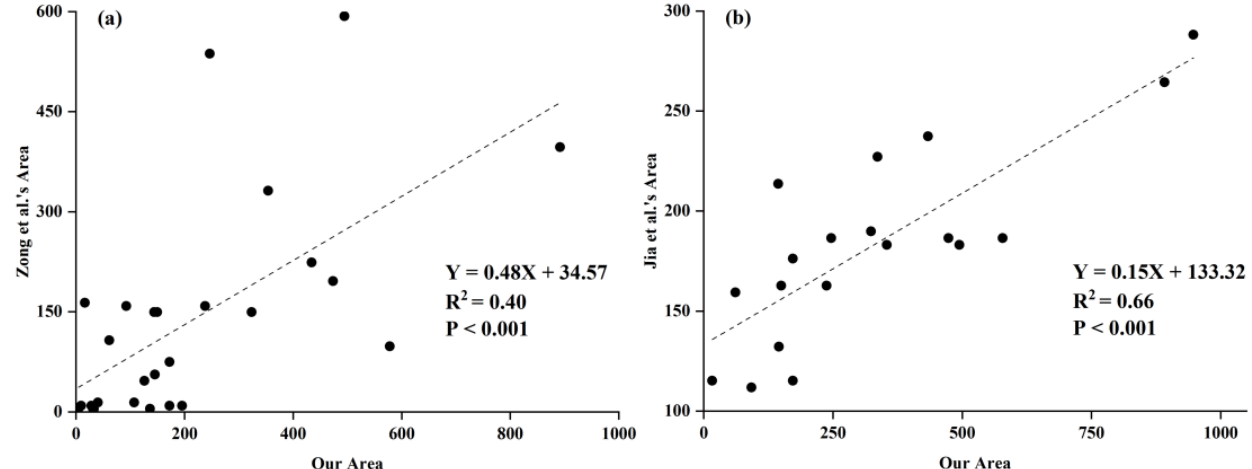
Figure 5. The linear regression between our annual cyanobacterial bloom area and that of Zong et al. [40] ( a ) and Jia et al. [16] ( b ).